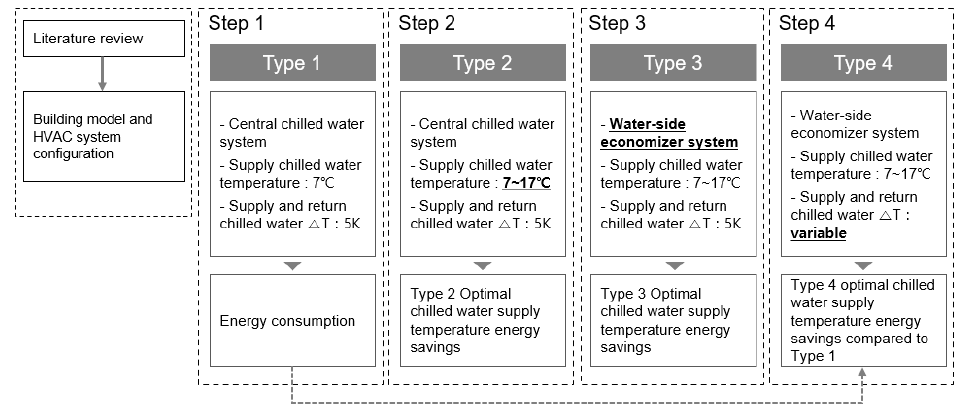
Figure 1. Flow chart of research.